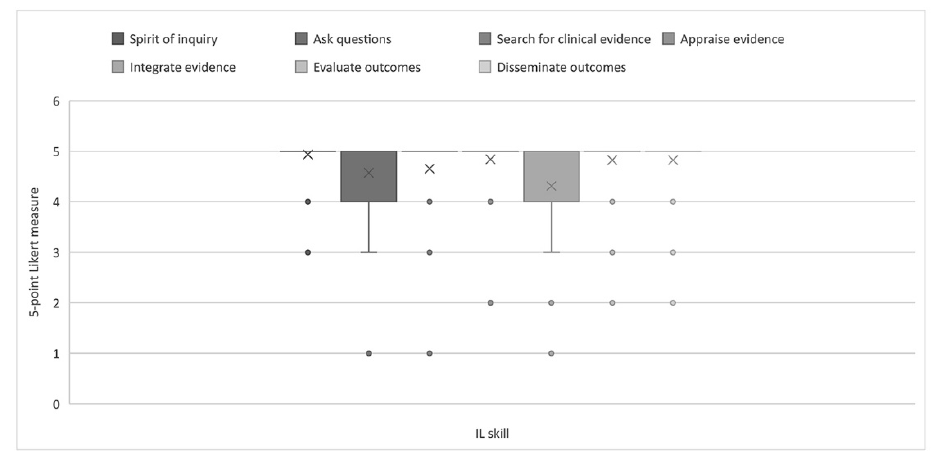
Figure 4 Nursing faculty ratings of relevance of IL skills at the doctoral (PhD)